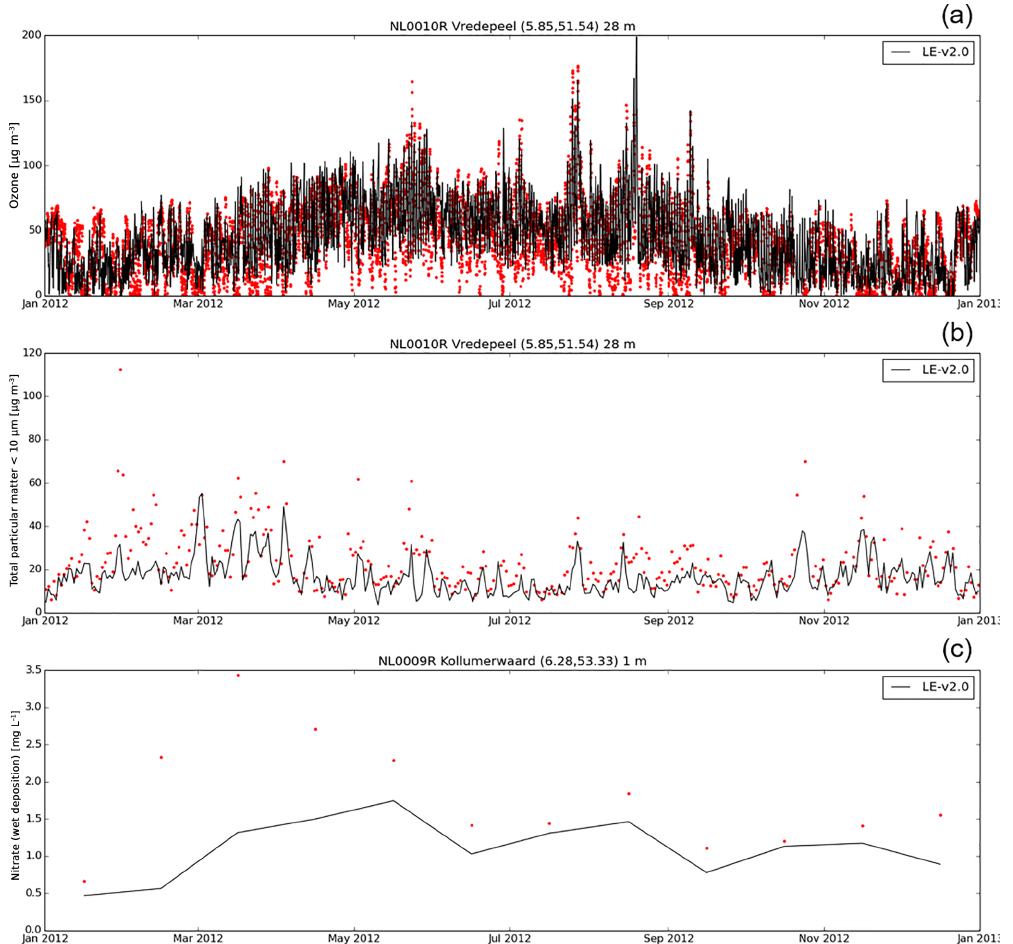
Figure 4. Time series of observed (red dots) and modelled concentrations (black lines) of ozone (a) and PM 10 (b) at Vredepeel (the Nether- lands, 51.54 ◦ N, 5.85 ◦ E) and concentrations of NO 3 in rainwater (c) in Kollumerwaard (the Netherlands, 53.33 ◦ N, 6.28 ◦